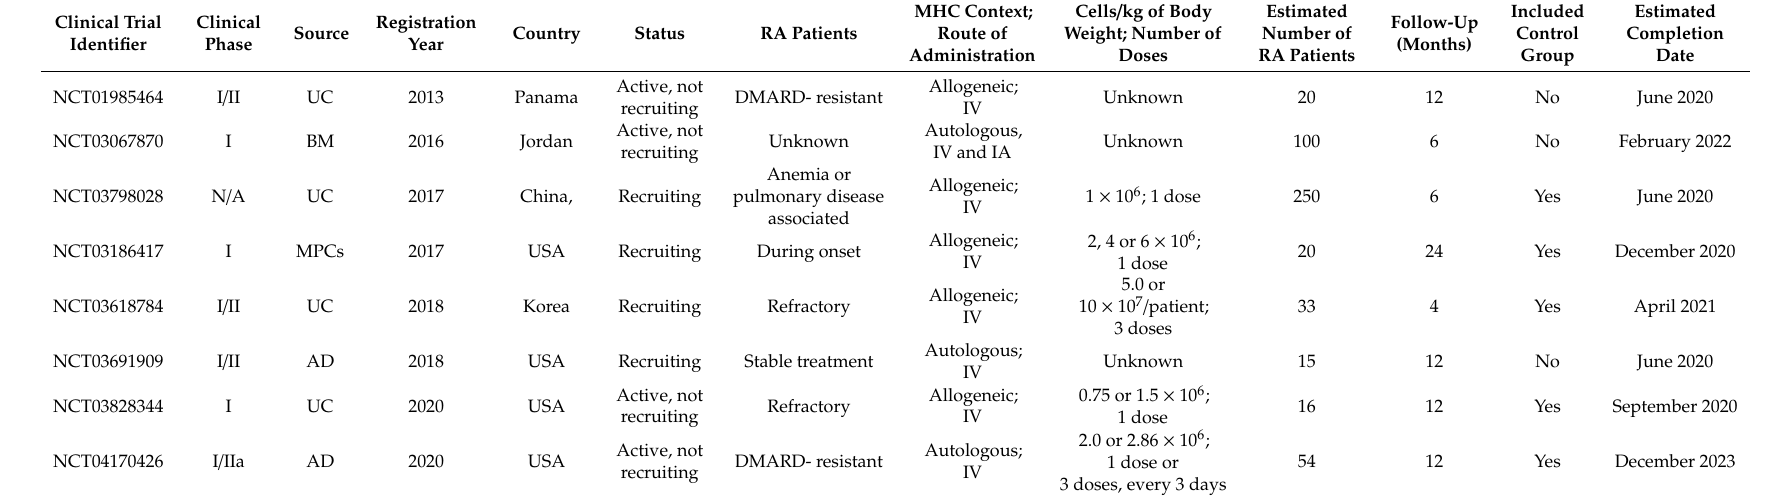
Table 3. Summary of active RA clinical trials with MSC